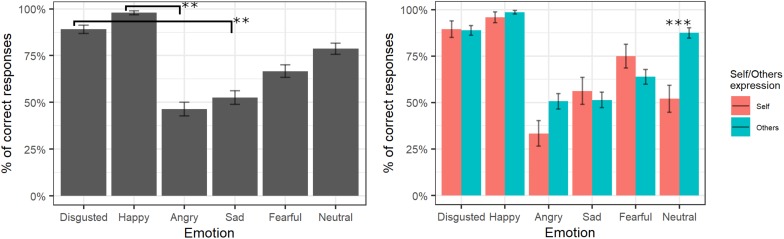
Percentage of correctly identified emotions in the main experiment. Significant differences between emotions are highlighted with asterisks (left panel, **<0.01). Percentage of correct identifications for self/other expression are depicted on the right panel, with asterisks highlighting self vs. other differences (***<0.001).